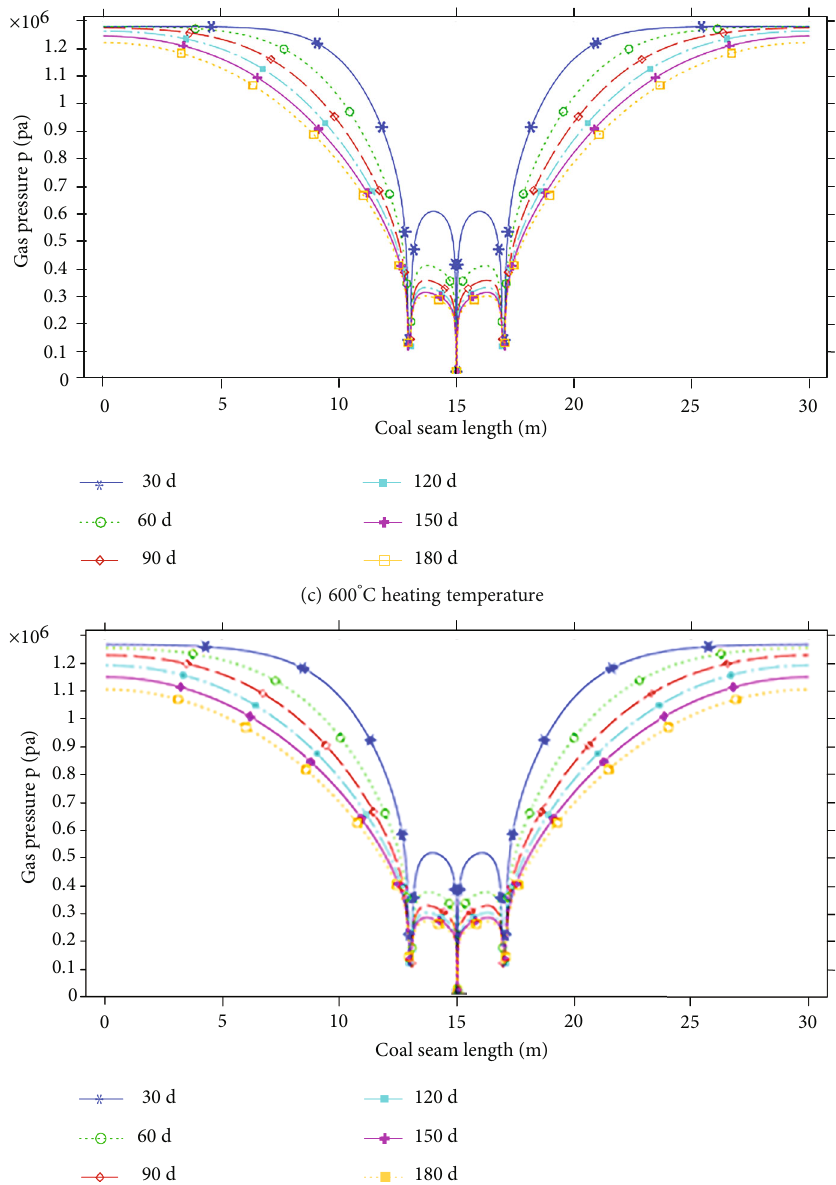
Figure 7: Pressure distribution of 180d gas drainage under di ff erent heating